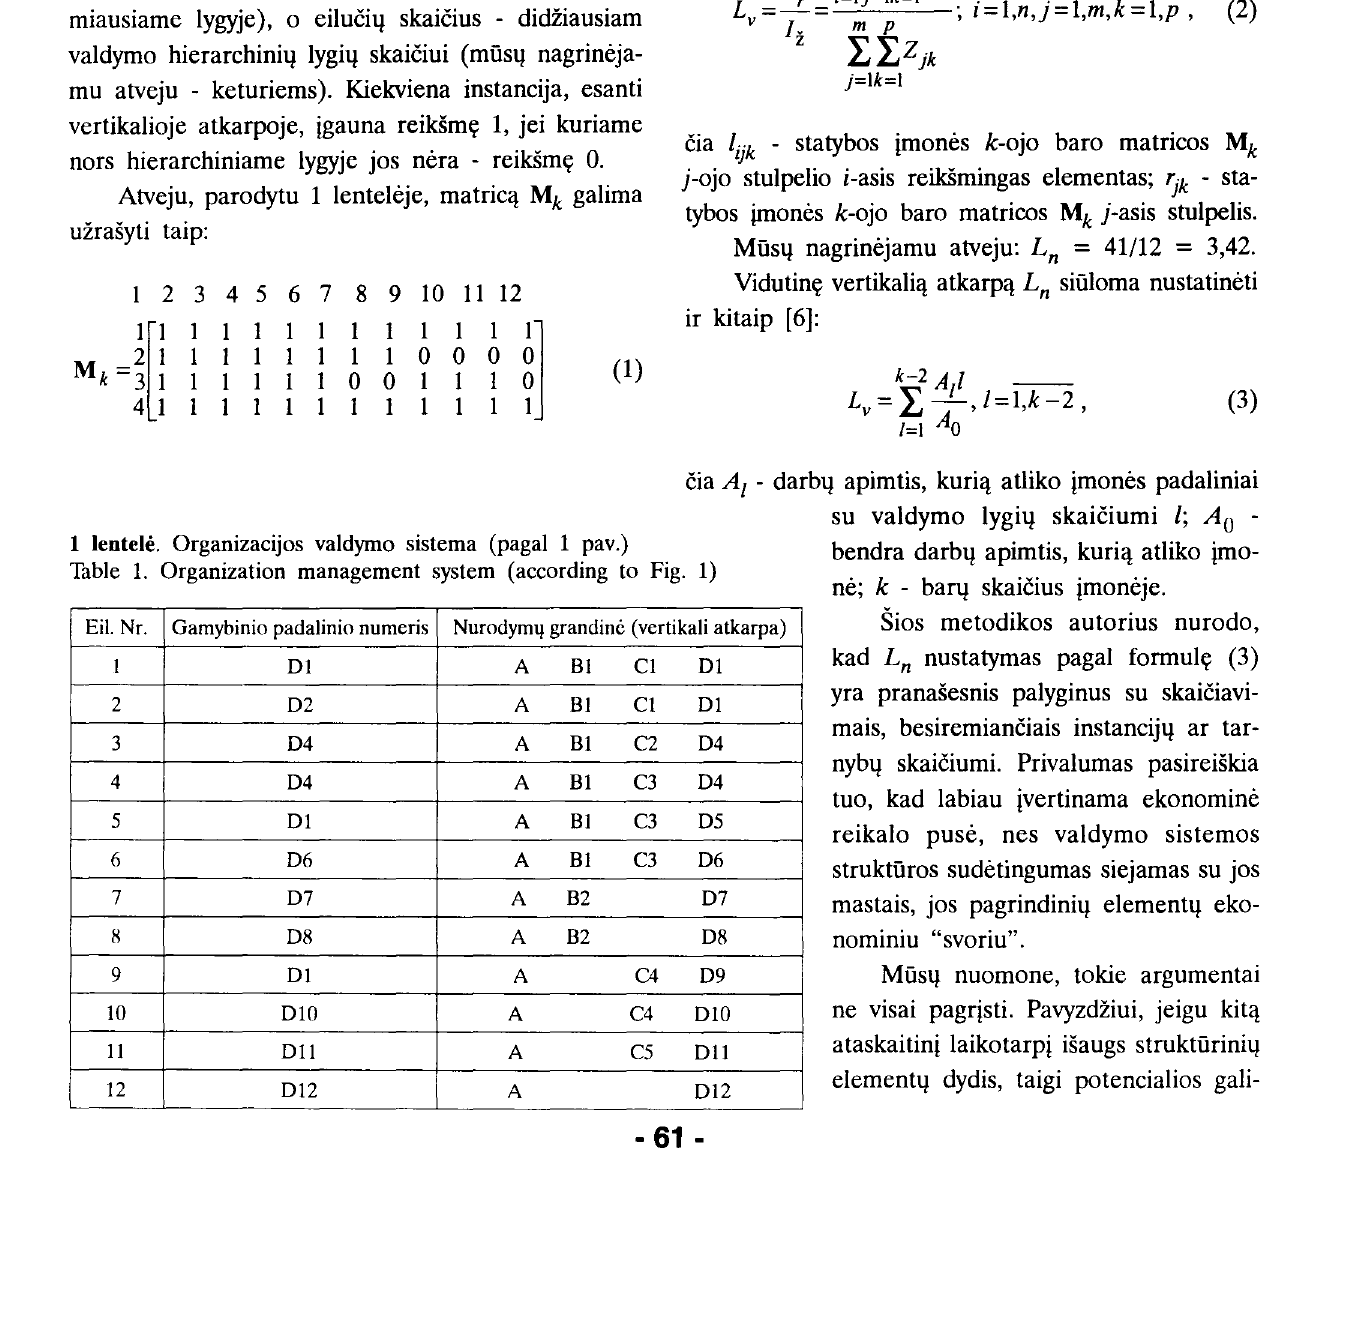
Fig. 2. Organigram of enterprise management system